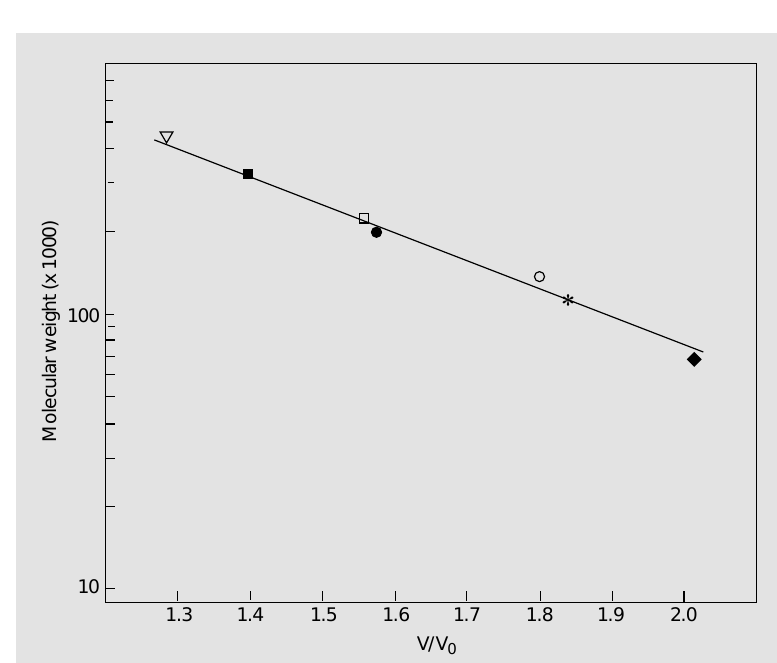
Figure 5. Molecular mass determination of C 12 E 8 -solubilized Na,K-ATPase. Molecular mass was determined using a Sepharose 6B column (0.8 x 133 cm) equilibrated and eluted with